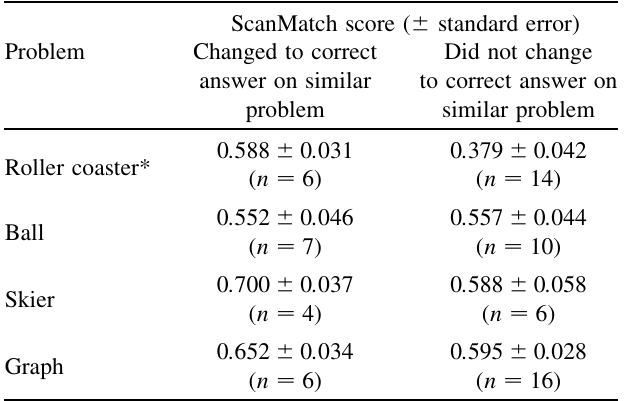
TABLE II. ScanMatch scores for cued participants who did and participants who did not answer a similar problem correctly. An asterisk indicates a significant difference at the (cid:1) ¼ 0 : 05